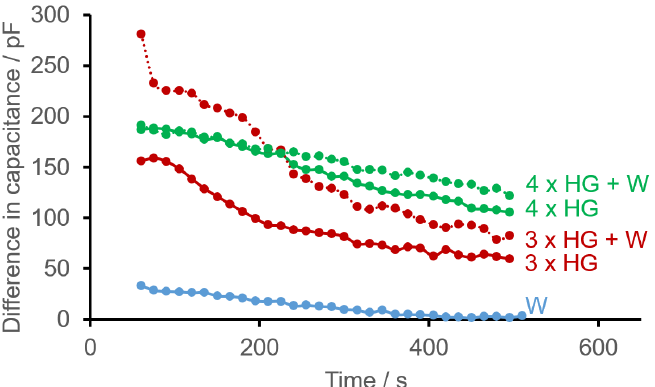
Figure 6. Examples of time courses of differences in capacitance ∆ C ( = C cur − C dry ) between the current reading (cur) and that of the dry PCB (dry) of a ceramic PCB with the sensor structure double meander M2 after spraying on various combinations of three or four bursts of hydrogel (HG) and water (W). Due to the rather random initial values and stabilization phase of the layer applied, the initial values are not shown for the sake of clarity.